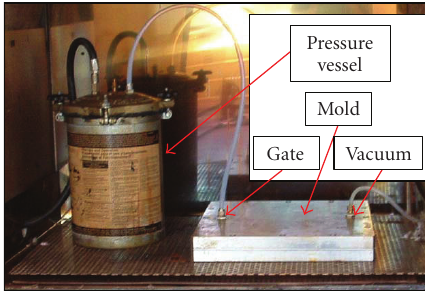
Figure 2: Experimental apparatus for RTM process.